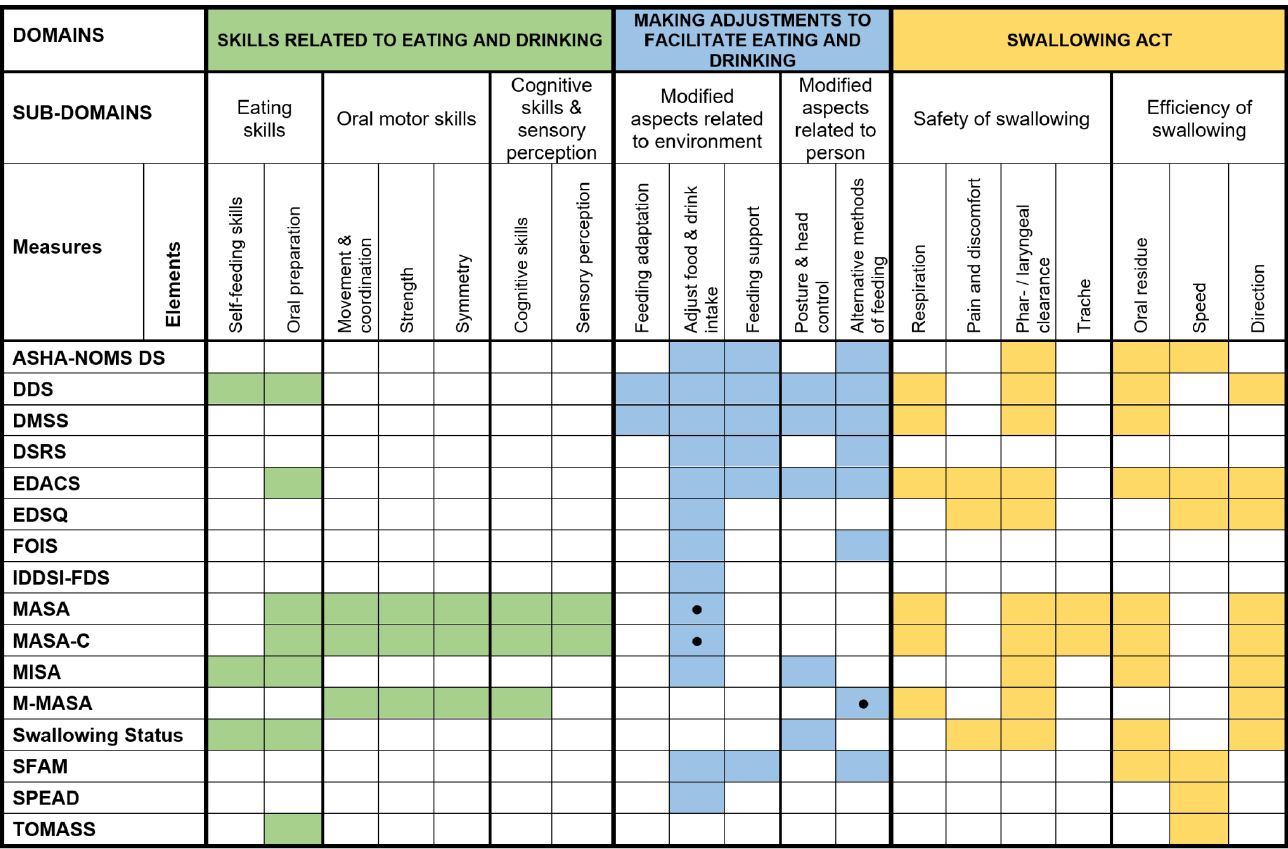
Figure 2. Conceptual mapping of non-instrumental clinical measure items. Note. Legend background colours. Green = Skills related to eating and drinking; Blue = Making adjustment to facilitate eating and drinking; Yellow = Swallowing act. • = Item, but not part of scoring; ASHA-NOMS DS = ASHA-NOMS Dysphagia Scale; DDS = Dysphagia Disorders Survey; DMSS = Dysphagia Management Staging Scale; DSRS = Dysphagia Severity Rating Scale; EDACS = Eating and Drinking Ability Classification System; EDSQ = Easy Dysphagia Symptom Questionnaire; FOIS = Functional Oral Intake Scale; IDDSI-FDS = International Dysphagia Diet Standardisation Initiative Functional Diet Scale; MASA = Mann Assessment of Swallowing Ability; MASA-C = Mann Assessment of Wallowing Ability-Cancer; MISA = McGill Ingestive Skills Assessment; M-MASA/mMASA = Modified Mann Assessment of Swallowing Ability; SPEAD = Swallowing Proficiency for Eating and Drinking; TOMASS = Test of Masticating and Swallowing